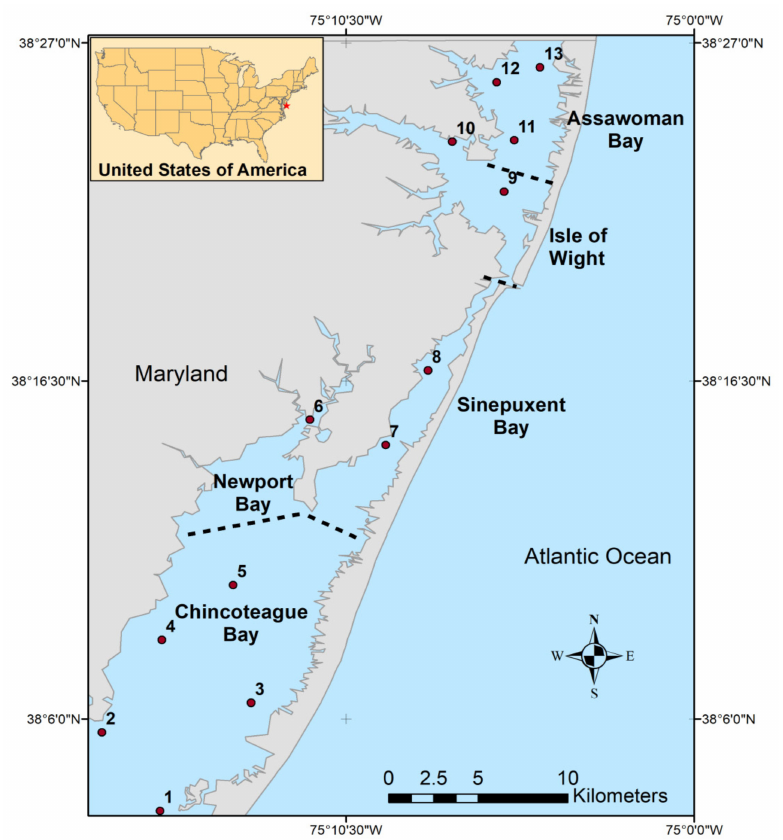
Figure 1. Map of the study area showing sampling locations within the Maryland Coastal